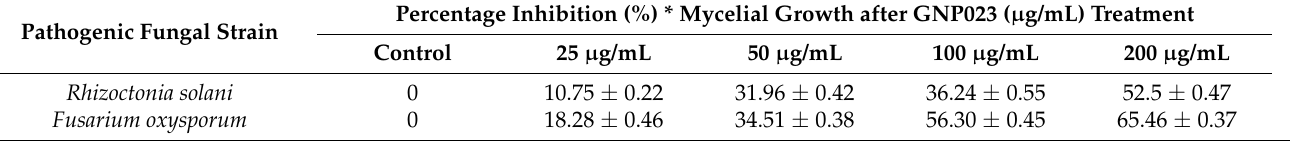
*: mean diameter on zone of inhibition ± Standard Deviation ( n = 3).